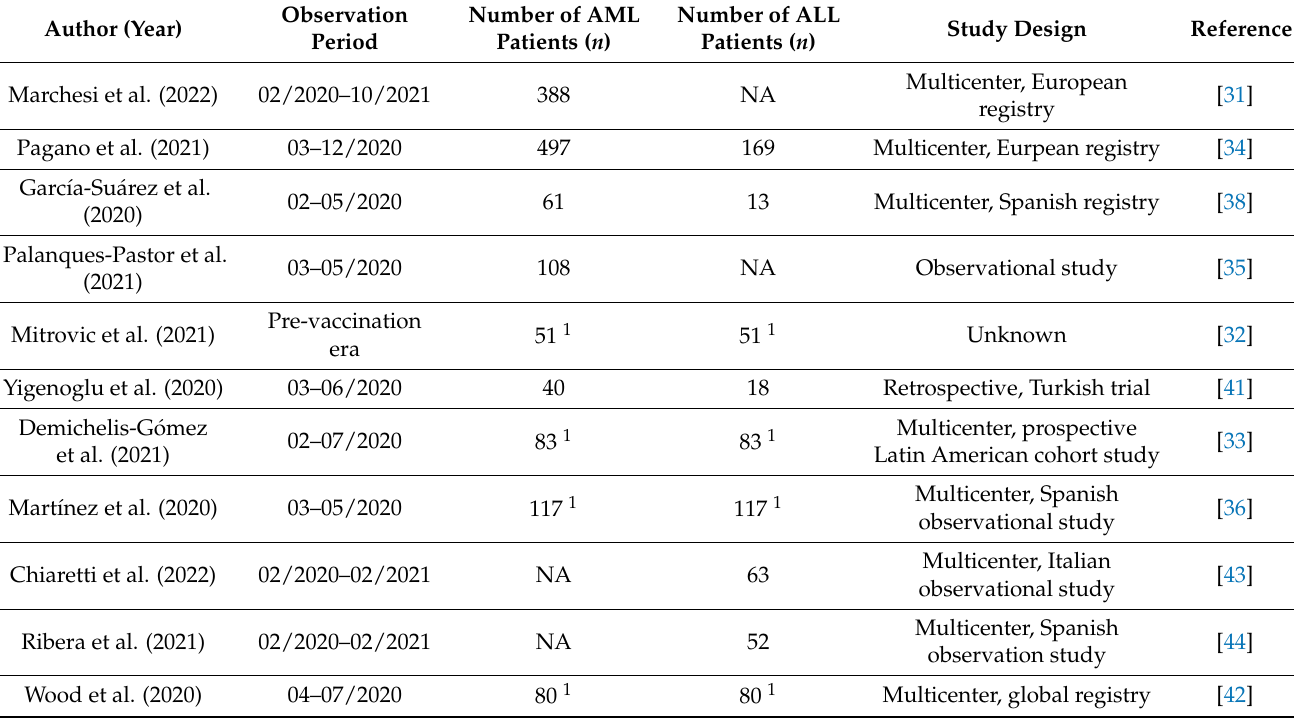
Table 1. Overview of the most important studies on clinical courses of COVID-19 in patients with acute leukemia (Part 1 including study design and number of study